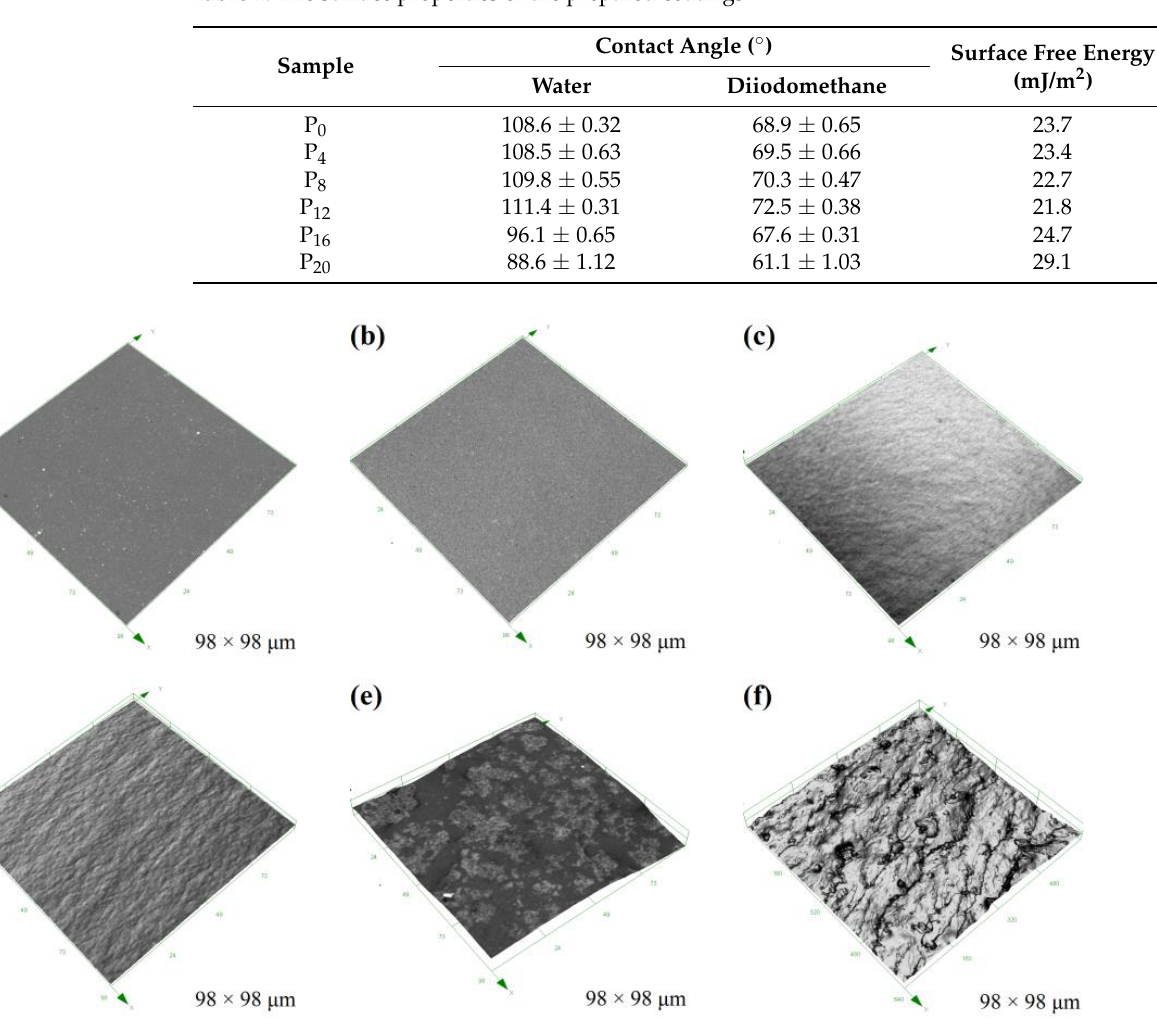
Figure 4. The surface roughness values of the prepared coatings.